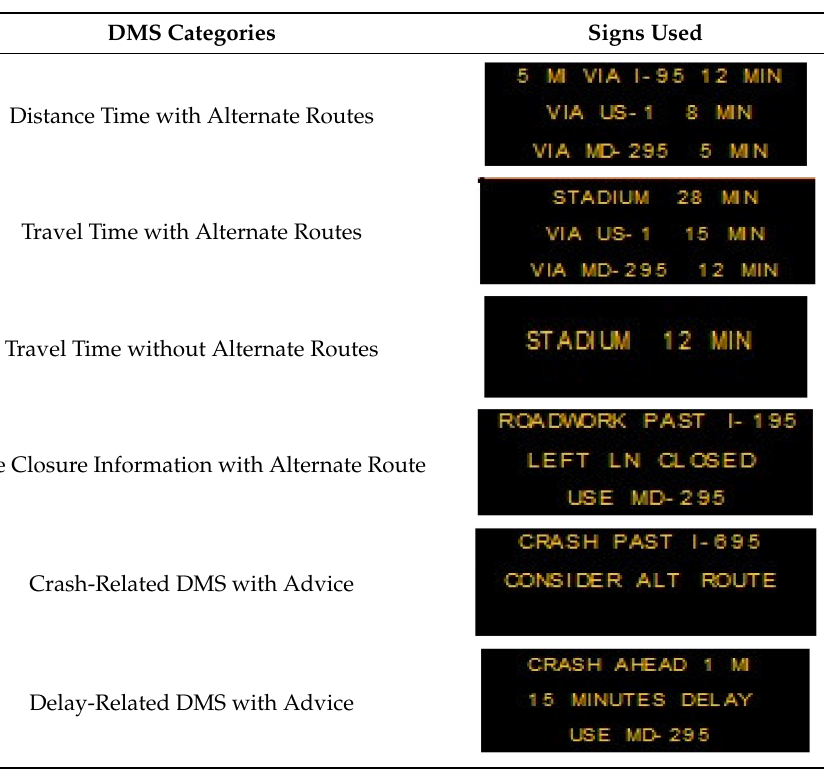
Figure 4. Study Network. Table 2. List of DMS signs utilized in this